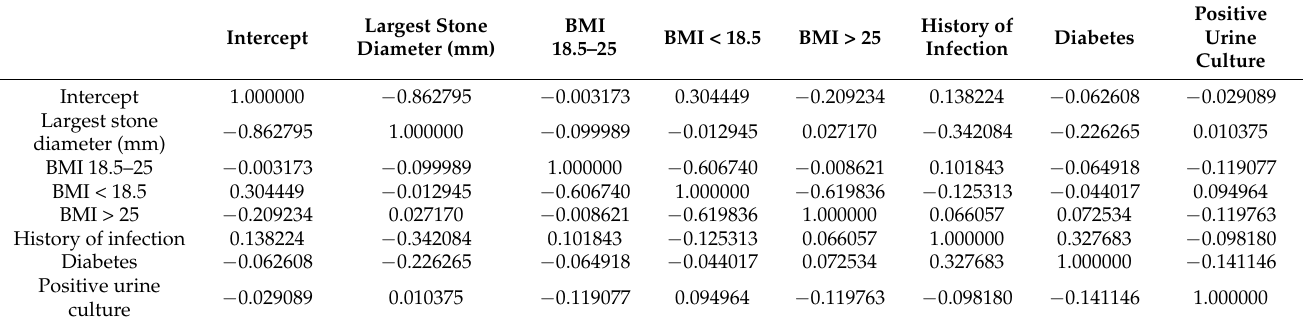
Table 6. Estimated correlation